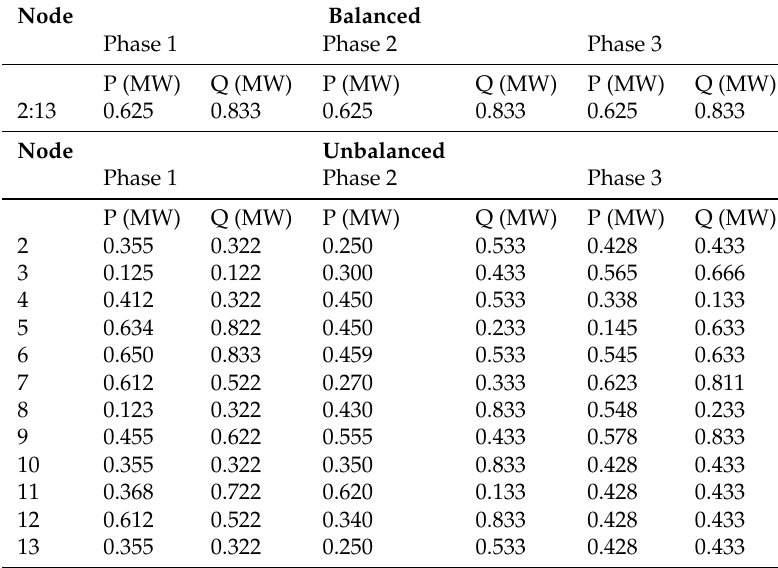
Figure 7. The combined overhead line and underground cable distribution case study. Table 2. Load values and